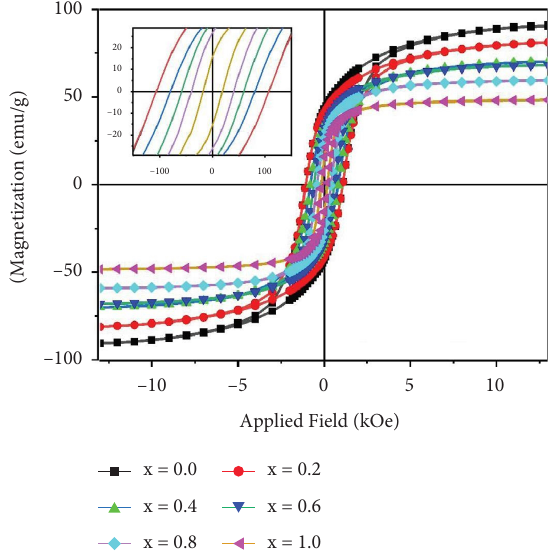
Figure 14: Magnetic hysteresis loops for Co 1 − x Ni x Fe 2 O 4 (where x � 0.0 ≤ x ≤ 1.0) nanoferrite particle samples calcinated at 800 ° C; inset showing magnifed hysteresis loops under low magnetic